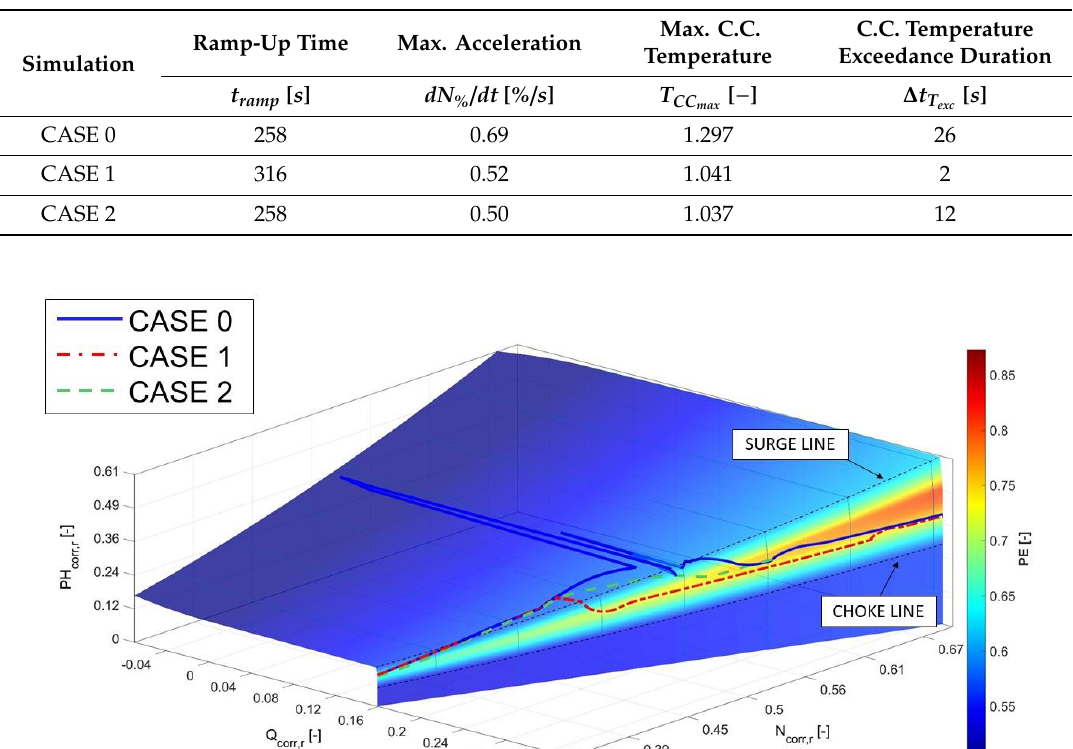
Figure 7. Start-up simulation up to Grid Synchronization. Compressor operative point on the performance map corrected with respect to the speed of sound and expressed in terms of volume flow rate, polytropic head, speed, and polytropic efficiency. All these variables are normalized with respect to their FSFL values.